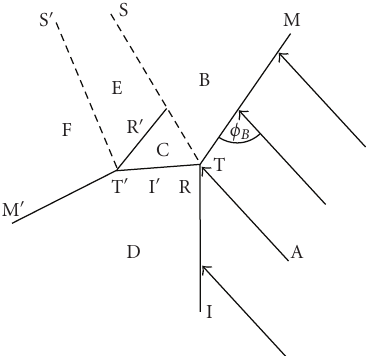
Figure 24: Sketch of a triple point with double Mach reflection structure.